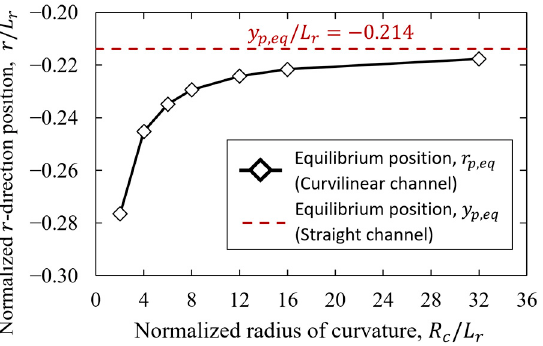
Figure 6. Segr é –Silberberg effects at each radial length of curvature for l = 200 cells, Re = 27.54 and C = 0.25 and equilibrium position of particle in straight channel y p , eq .